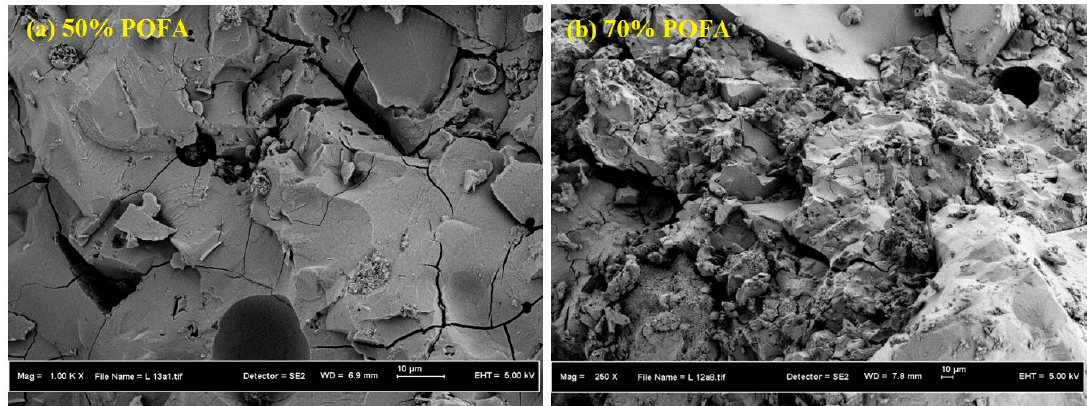
Figure 9. SEM images of AAM mix designs with ( a ) 50% and ( b ) 70% POFA contents.